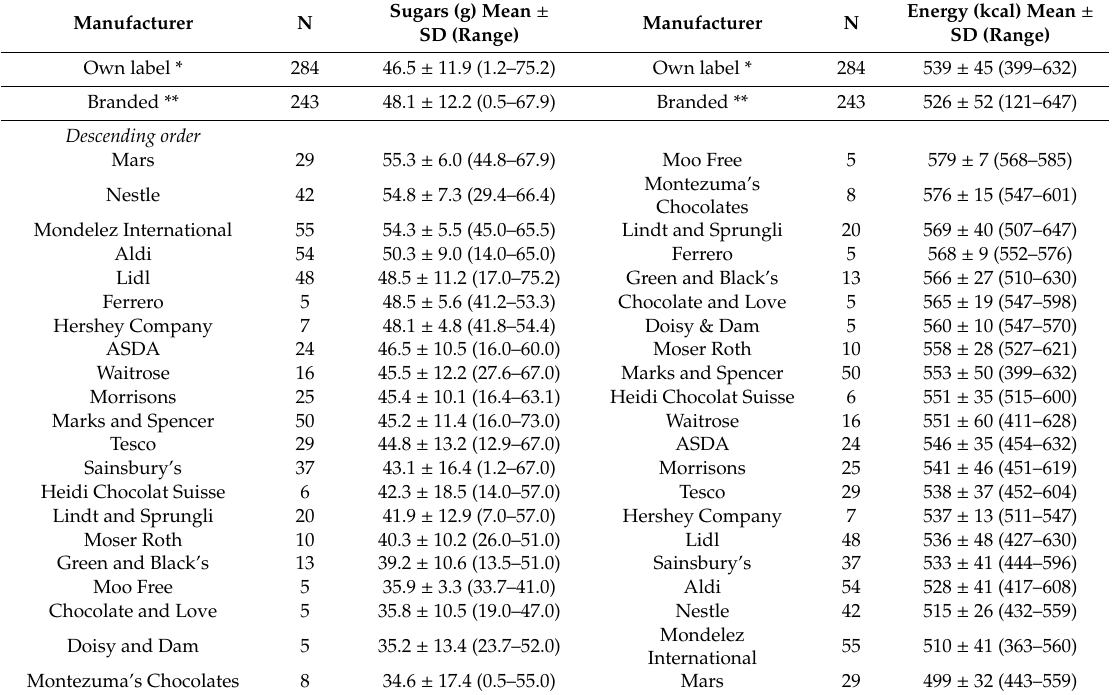
Table 5. Sugar and energy contents of chocolate confectionery by manufacturer per 100 g in